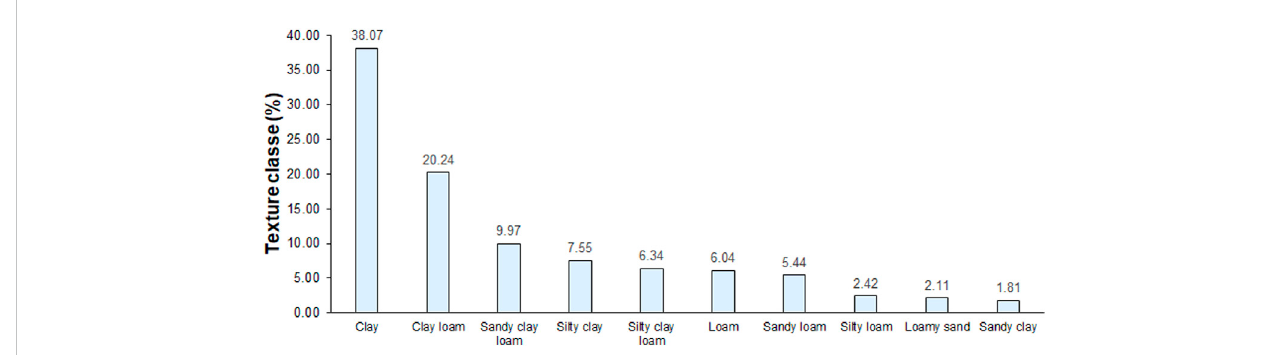
FIGURE 2 Distribution of texture classes of soil samples for all regions.